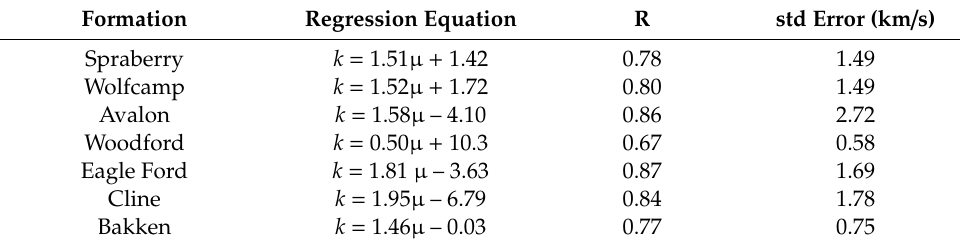
Table 5. Bulk modulus ( k ) versus shear modulus ( µ ) relationships by formation’. Moduli are given in GPa. R is the correlation coe ffi cient and std error is the standard deviation of the prediction residual. The F-test was greater than 100 and the sig F statistic was virtually zero in all cases. The trends are similar excepting the Woodford shale. The mean absolute error for all datapoints using these individual relationships is 1.7%. The anomalous Woodford Shale relationship can be explained as being due to interbedding of siliceous and non-siliceous thin layers. Moduli are in GPa. Formation Regression Equation R std Error (km / s) Spraberry k = 1.51 µ + 1.42 0.78 1.49 Wolfcamp k = 1.52 µ + 1.72 0.80 1.49 Avalon k = 1.58 µ – 4.10 0.86 2.72 Woodford k = 0.50 µ + 10.3 0.67 0.58 Eagle Ford k = 1.81 µ – 3.63 0.87 k = 1.95 µ – 6.79